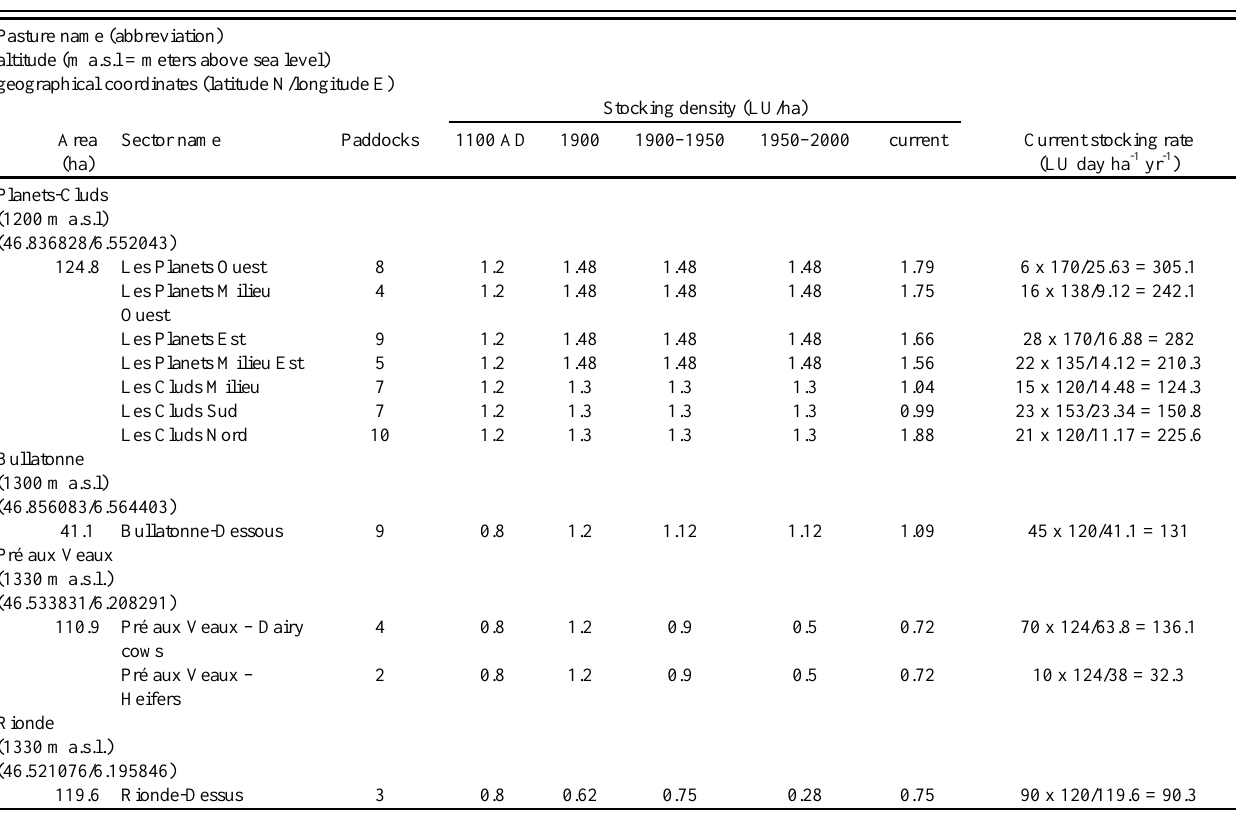
Table 1 . Hierarchical structure of management units and corresponding historical and recent stocking rates. The complex of neighboring pastures Les Planets and Les Cluds is abbreviated as “Planets-Cluds,” the pasture La Bullatonne-Dessous is abbreviated as “Bullatonne,” and La Rionde-Dessus is abbreviated as “Rionde.” Full names correspond to the Swiss National Map 1:25’000. Historical stocking in the Middle Ages is based on assumptions explained in the text. Stocking densities during the twentieth century are based on the FOAG (1972, 1974). The current stocking rate is calculated according to Allen et al. (2011) as the product of livestock units (LU) and grazing duration per year, divided by the grazed area. Pasture name (abbreviation) altitude (m a.s.l = meters above sea level) geographical coordinates (latitude N/longitude